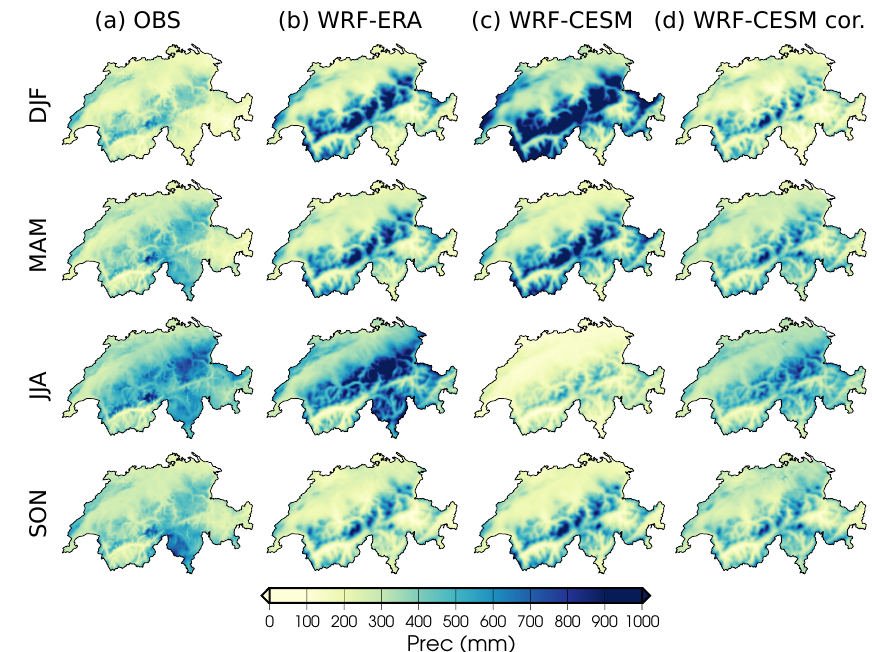
Figure 6. Mean seasonal accumulated precipitation over Switzerland across seasons (different rows) in the gridded observations (a) , the WRF-ERA simulation (b) , the WRF-CESM simulation (c) and the bias-corrected WRF-CESM simulation (d) .